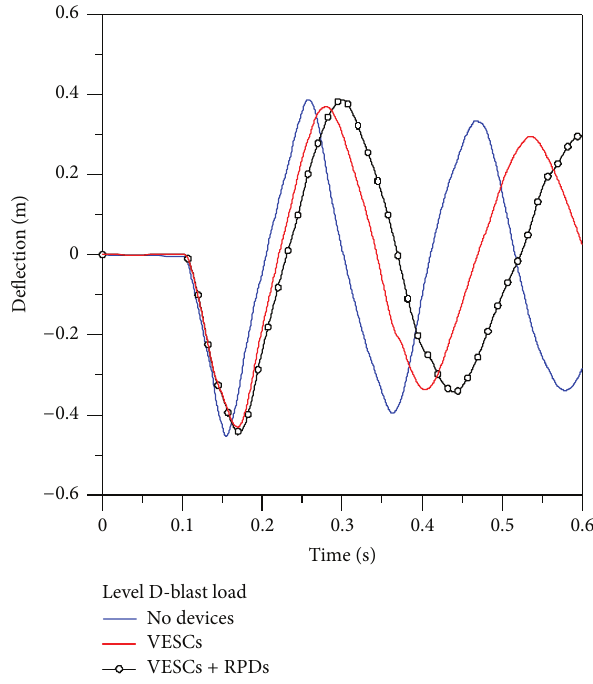
Figure 11: Midspan cable deflection as a function of time